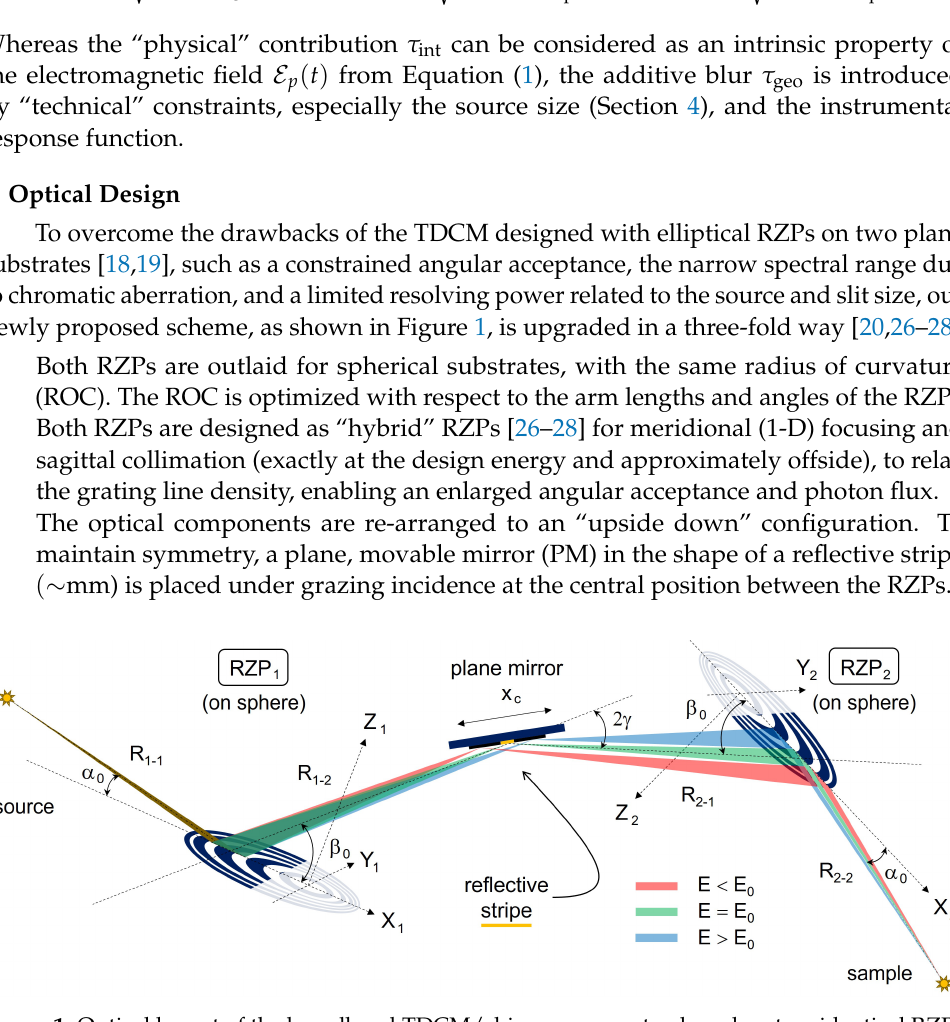
Figure 1. Optical layout of the broadband TDCM/chirp compensator, based on two identical RZPs for 1-D focusing (mer.)/collimation (sag.) on spherical substrates. Polychromatic source emission is drawn in brown. The design energy E 0 is displayed in green, and red-/blue de-tuned X-ray energies E are addressed by moving the reflective stripe (yellow) of the plane mirror along the main optical axis, to the position x c , which refers to the desired central energy E c for monochromatization (Section 5). The parameters in both local coordinate systems for RZP 1,2 follow the nomenclature in the